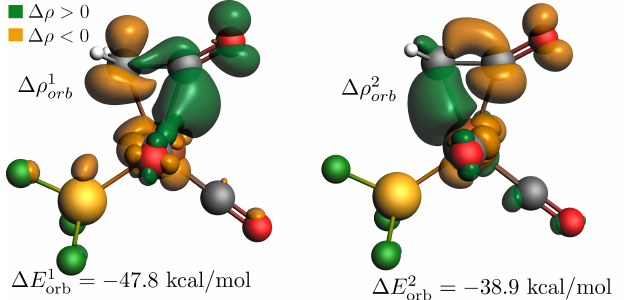
Figure 8. NOCV deformation densities associated with the dominant two interactions of the ketene complex 9F2